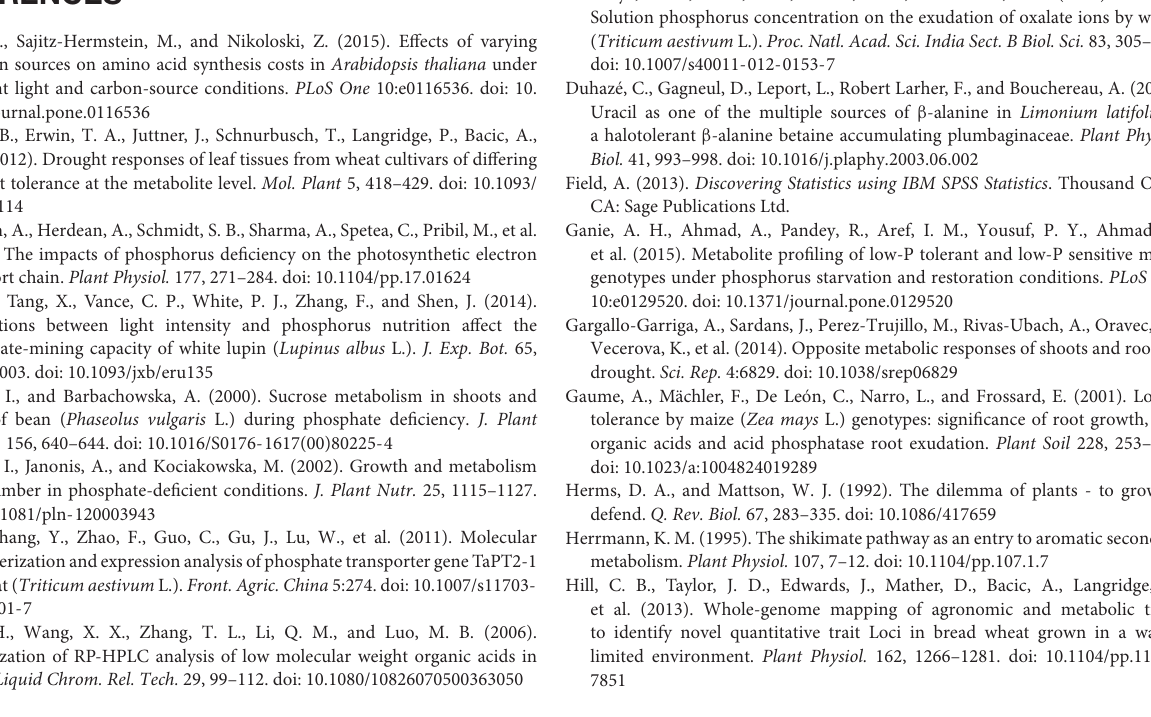
grown at 10 mg P kg − 1 soil. TABLE S1 | Basal nutrient mix (mg kg − 1 soil) added to the growth medium. TABLE S2 | Separation conditions used for HPIC analysis of organic acids. TABLE S3 | Fold-change in metabolite levels in shoots of P efficient RAC875 and P inefficient Wyalkatchem. Comparisons between low P supply and adequate P supply (low P/adequate P); and between RAC875 and Wyalkatchem (RAC875/Wyalkatchem) at each P supply. R, RAC875; W, Wyalkatchem; Low P,